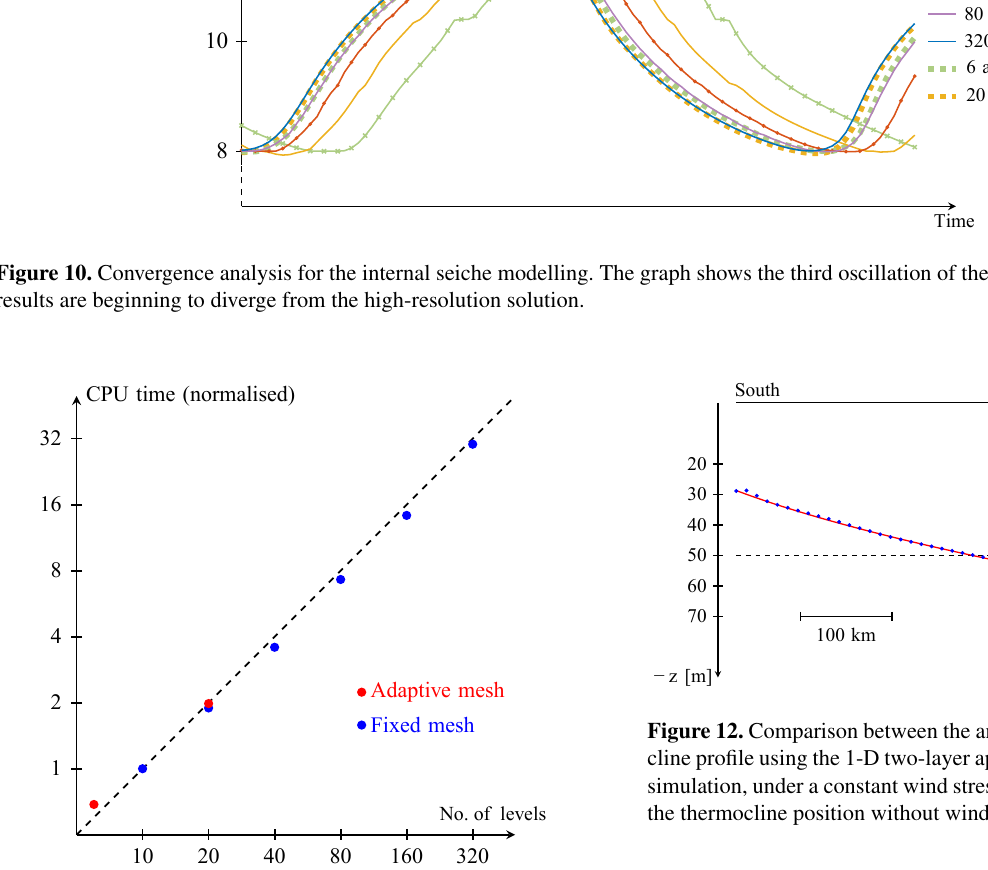
Figure 11. CPU time of the simulations for a different number of levels (using a log–log scale). CPU times are normalised by the 10 fixed levels of simulation time. As expected, CPU time is propor- tional to the number of levels. Moreover, the computational over- head of adaptive levels is negligible. For the same computational cost, the adaptive method is then much more accurate (Fig. 10).